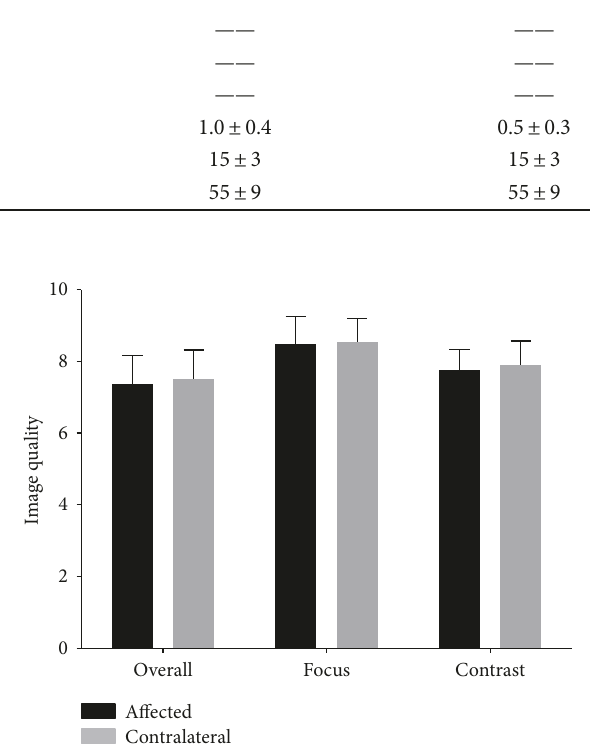
Figure 2: Image quality scores between the a ff ected eyes and contralateral eyes. No di ff erence was signi fi cant between the a ff ected and contralateral eyes in overall quality, focus, or contrast scores. The paired t -test was used in the overall and focus comparison, resulting in p values of 0.194 and 0.400, respectively. The Wilcoxon matched pair signed rank sum test was used in the contrast comparison, resulting in a p value of